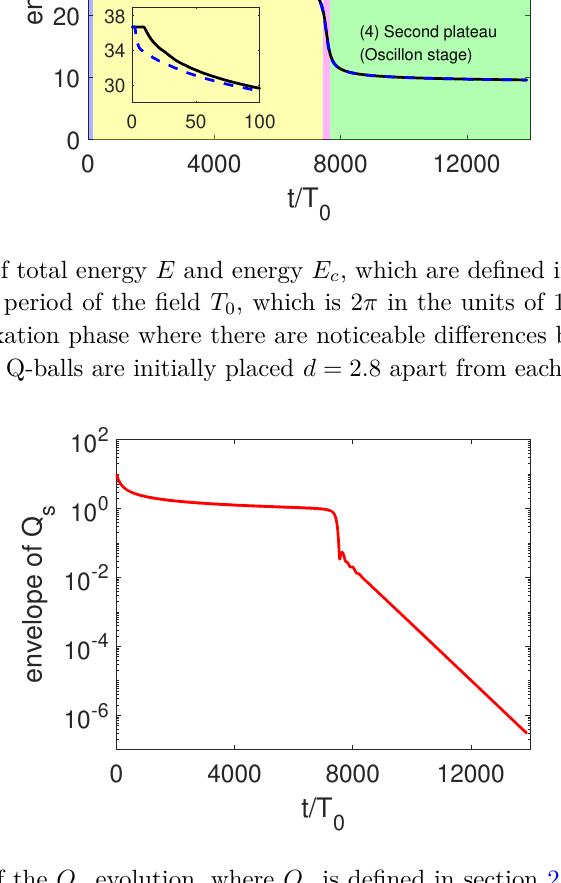
Figure 9. Envelope of the Q s evolution, where Q s is defined in section 2.1. Q s oscillates quickly according to the charge swapping frequency T within the envelope. All the settings are identical swap to figure 8. T = 2 π/m is roughly the oscillation period of the field φ 0